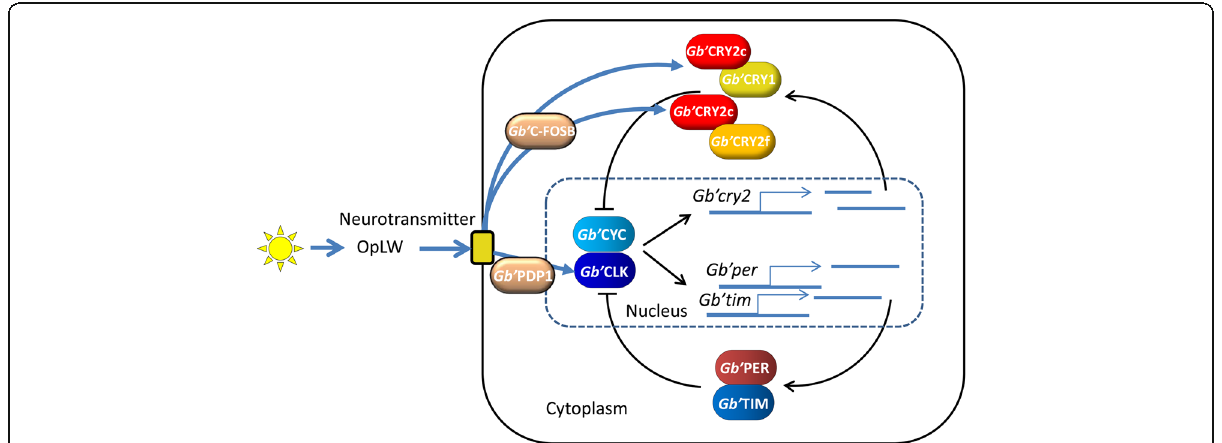
Fig. 6 A model for the light entrainment mechanism of the cricket circadian clock. The clock includes two major oscillatory loops, one for Gb ’ per and Gb ’ tim, like in Drosophila, and the other for Gb ’ cry2 . The latter is comprised of Gb ’ cry1 and two Gb ’ cry2 isoforms, Gb ’ cry2c and Gb ’ cry2f , and their product proteins form a complex that suppresses the transcription mediated by Gb ’ CLK/ Gb ’ CYC complex [23]. Light is perceived by the retinular cells in the compound eye expressing Gb ’ opLW , and the information is transmitted to the clock neuron in the optic lobe through neurotransmitters. This neurotransmission causes upregulation of Gb ’ c-fosB in the clock neurons, which finally affects the Gb ’ cry2 oscillatory loop. The change in the Gb ’ cry2 loop may reset the whole clock system since the Gb ’ cry2 loop interact with the Gb ’ per/Gb ’ tim loop by influencing Gb ’ CLK/ Gb ’ CYC. In addition to the Gb ’ cry2 pathway, the Gb ’ Pdp1 pathway resets the clock by upregulating Gb ’ Clk expression when light off was delayed